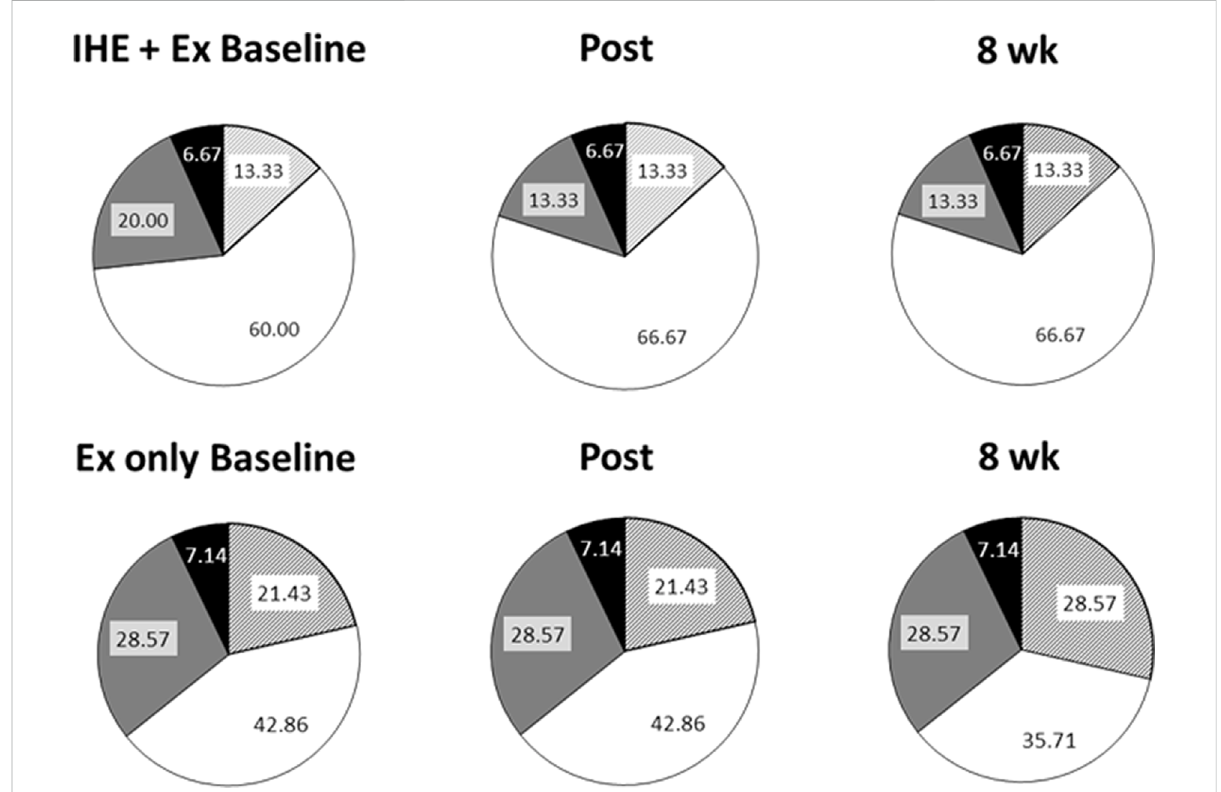
FIGURE 3 5-Year cardiovascular risk assessed using the New Zealand Guidelines chart. Pie graphs representing the de fi ned risk of cardiovascular disease in the next 5 years as determined by the New Zealand Guidelines Group. Striped portions: < 2.5% risk; White portions: 2.5% – 5% risk; Grey portions: 5% – 10% risk; and Black portions: 10% – 15%